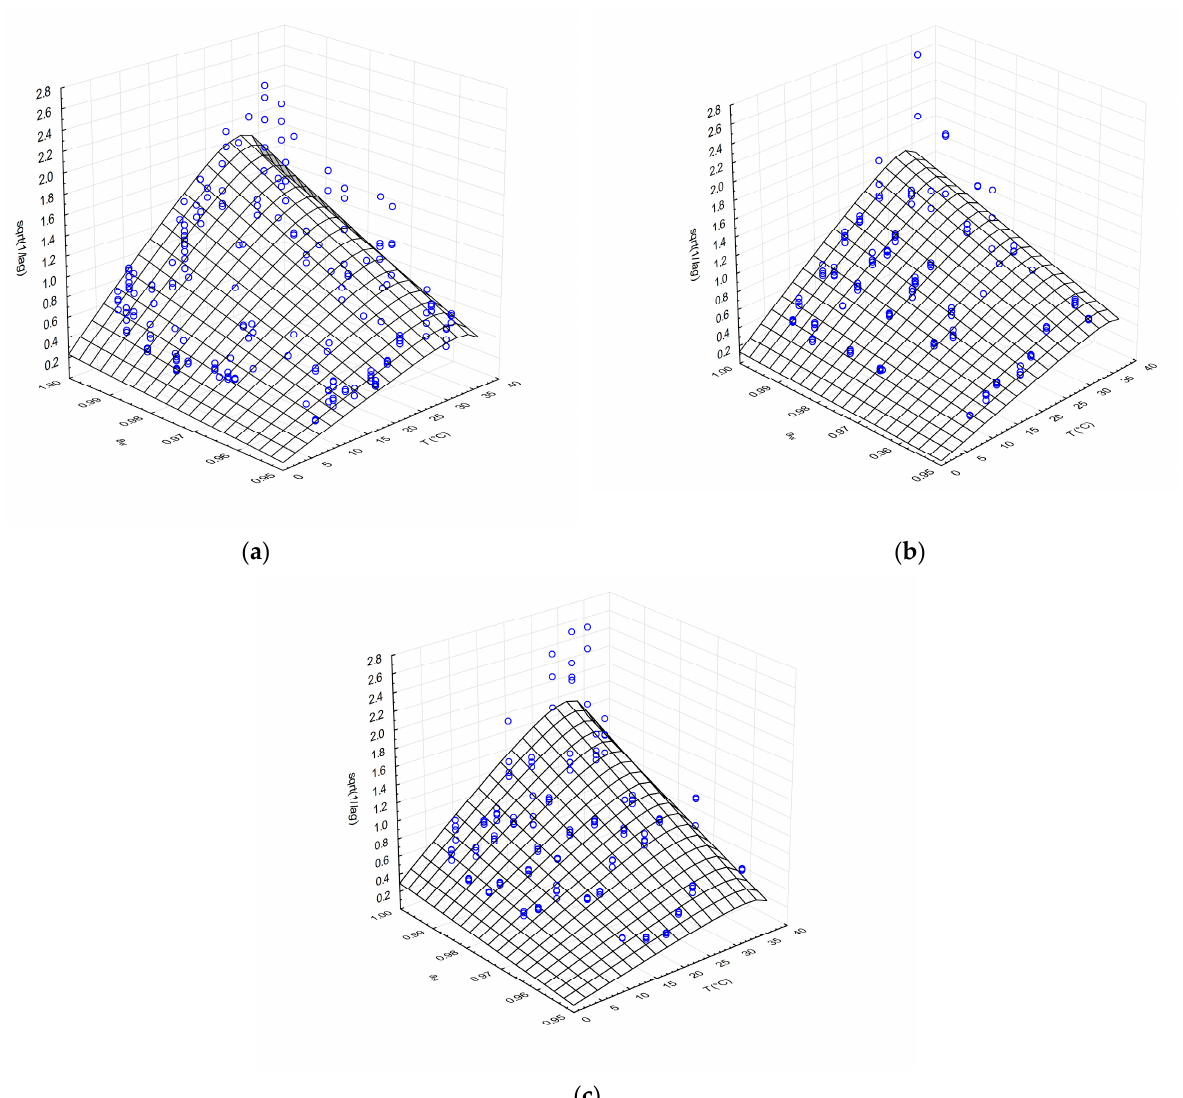
Figure 1. Effects of temperature and a w on the lag time ( λ ) of isolate G ( a ), isolate I ( b ) and collection strain CBS 557.83 of G. candidum ( c ) fitted with CM. Points ( ○ ) represent observed values of lag phase.